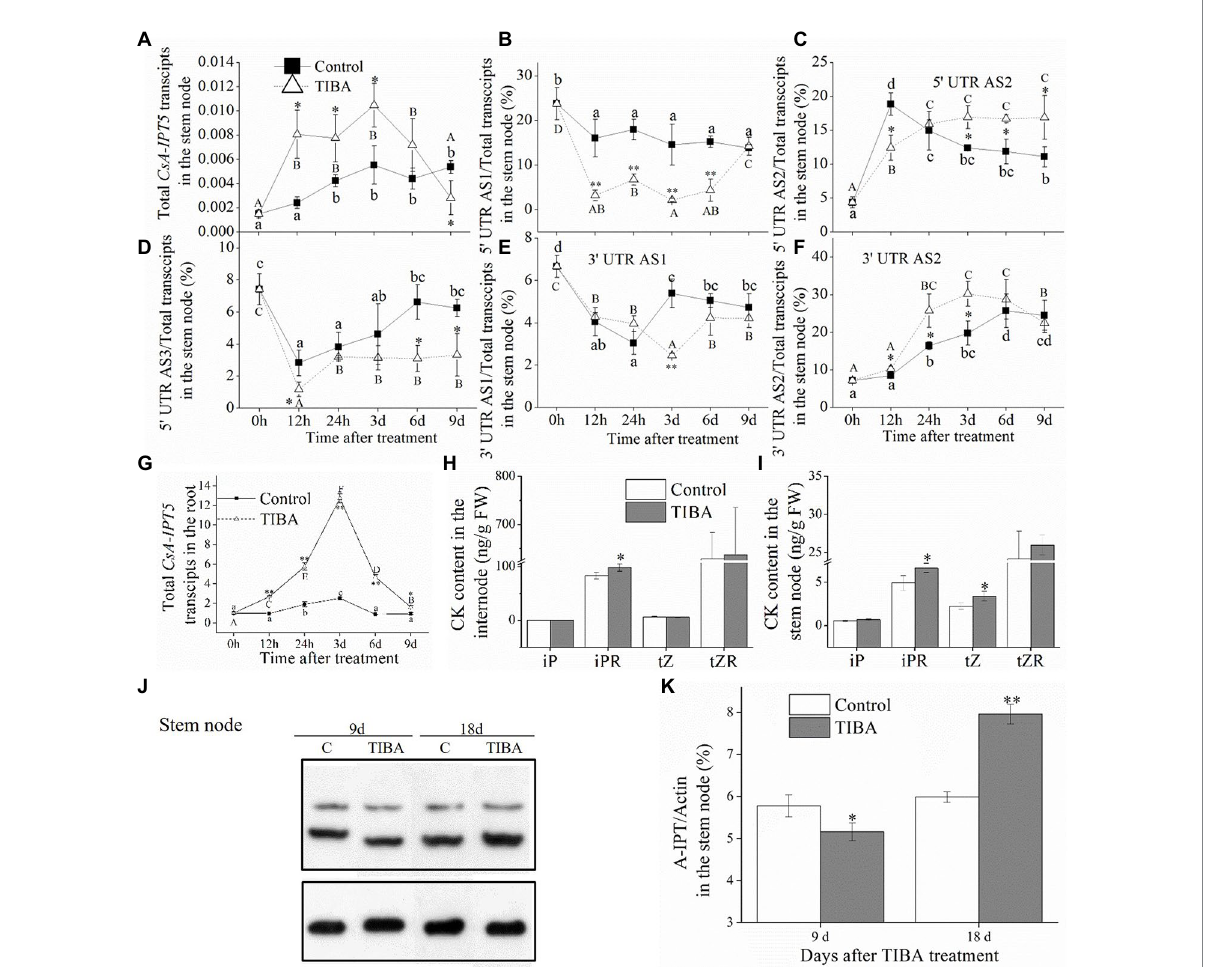
FIGURE 3 CKs concentrations in the internode and stem node, expression levels of CsA-IPT5 transcripts and CsA-IPT5 protein in the stem node and root induced by TIBA spraying. Expression levels of total CsA-IPT5 transcripts in the stem node or root at different time points stimulated by TIBA (A,G) . The ratios of CsA-IPT5 splice variations in the stem node at different time points stimulated by TIBA (B–F) . CK concentrations in the internode and stem node stimulated by TIBA (H,I) . Western blot (J) and ‘CsA-IPT5/Actin’ (K) display CsA-IPT5 protein expression in the stem node at 9 and 18 days after TIBA spraying. Data are means ± SD ( n = 3 or 6). Except for panels (H,I) , asterisks show marked differences in each index between control and TIBA spraying at each time point; for panels (H,I) , asterisks show marked differences in each index between control and TIBA spraying (** p < 0.01; Student’s t -test). In Figures (A–G) , letters show significant differences for each treatment among different time points ( p < 0.05, Duncan’s multiple range